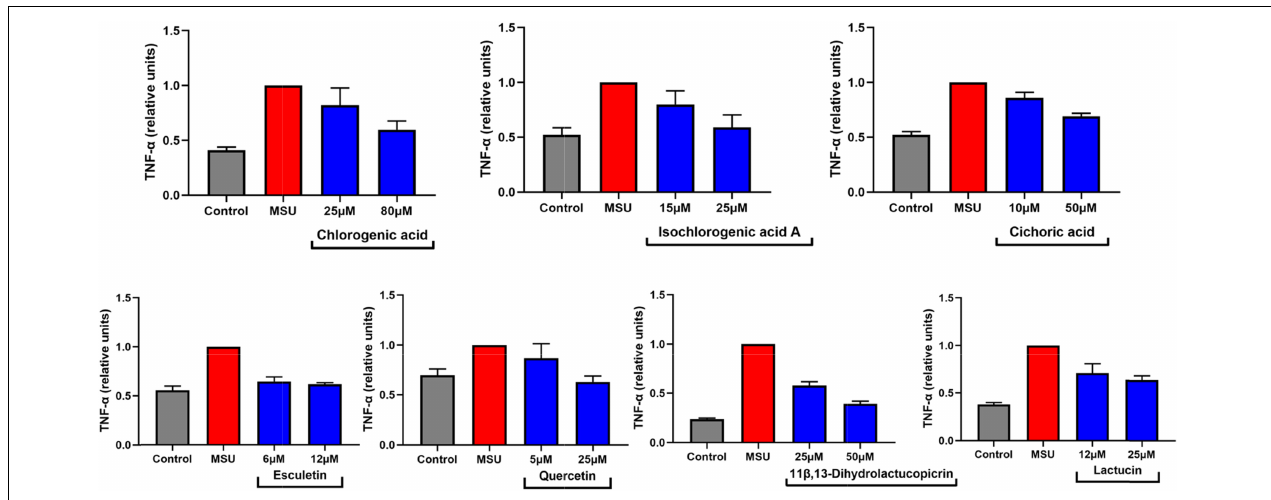
FIGURE 12 | Seven compounds in chicory inhibits TNF- α secretion of RAW264.7 cells induced by MSU. The secretion of TNF- α was measured in the supernatant of RAW264.7 cells by ELISA. MSU, monosodium urate; TNF- α , tumor necrosis factor- α . n = 3, mean ±